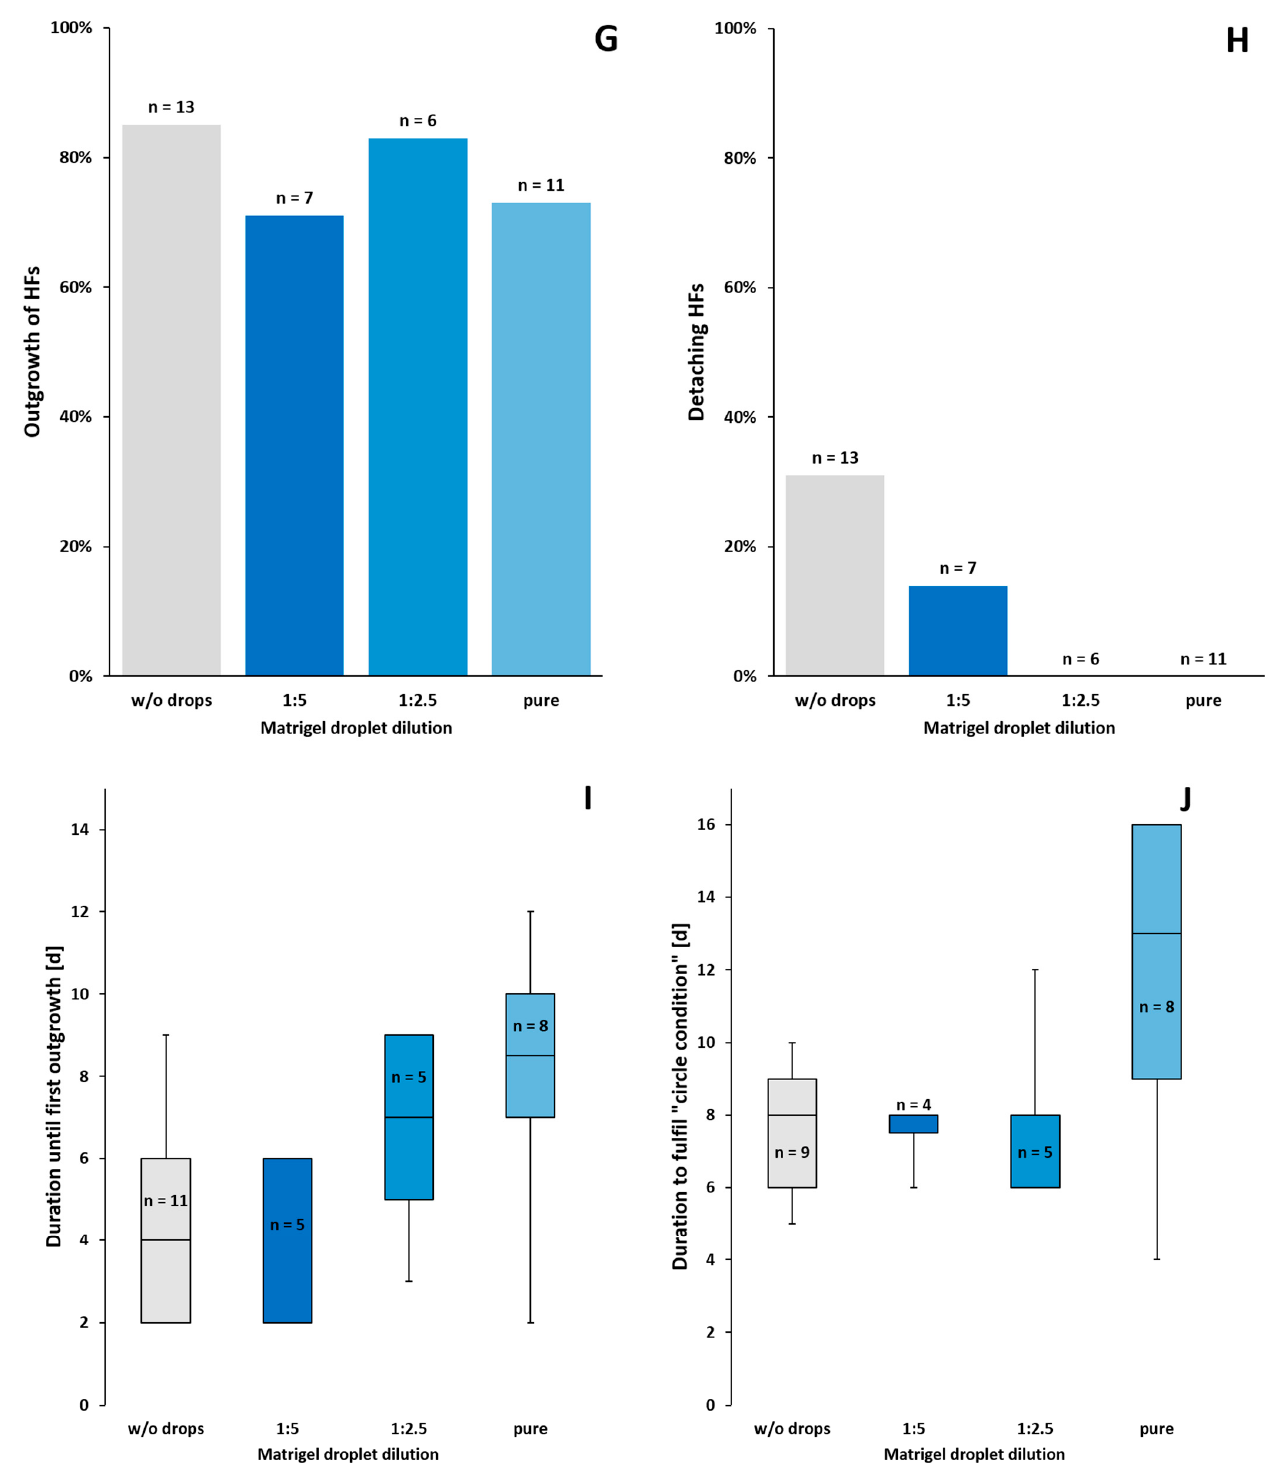
Figure 7. Influence of Matrigel droplet dilution on keratinocyte outgrowth. Keratinocyte growth behavior in different Matrigel mounting droplets (without drops (w/o); 1:5; 1:2,5; pure). DIC images of adherent keratinocytes growing under different coating conditions. After 6 days (6 d) of culturing ( A – C ) and after 2 weeks (2 w) of culturing ( D – F ). Relative outgrowth ( G ) and detaching ( H ) of HFs within four different Matrigel droplet dilutions. Analysis of the duration until the first outgrowth from HFs ( I ) and the time needed to fulfil the “circle condition” ( J ) with respect to the four different coating conditions. N = number of single, independent experiments. Scale bar: 500 µm.